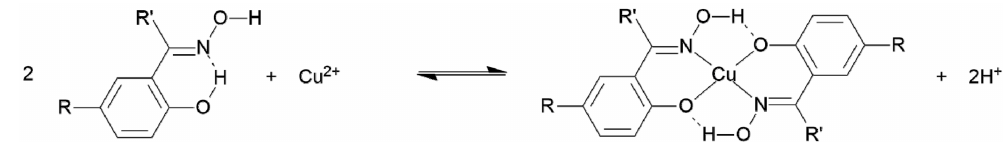
Figure 1. The pH-dependent extraction of Cu(II) by phenolic oximes.